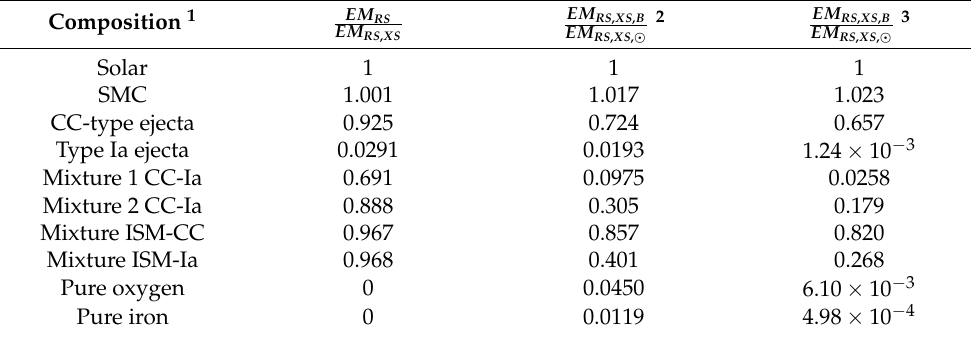
Table 2. Emission Measure